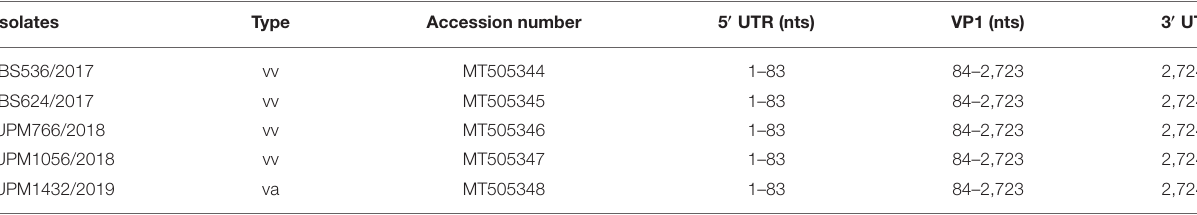
TABLE 2 | Complete genome annotation sequences of segment B of the study IBD viruses. Isolates